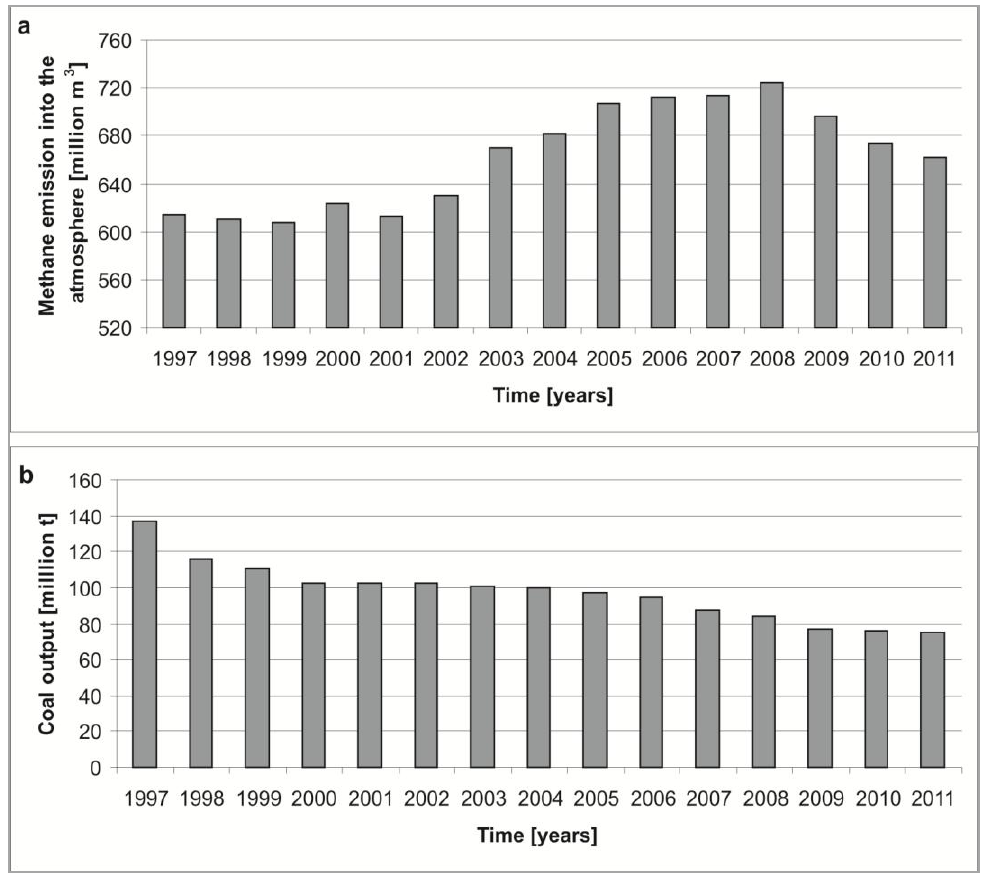
Fig. 4. Methane emission into the atmosphere from the coal mines of the USCB (a) compared to coal output (b), after Krause & Sebastian